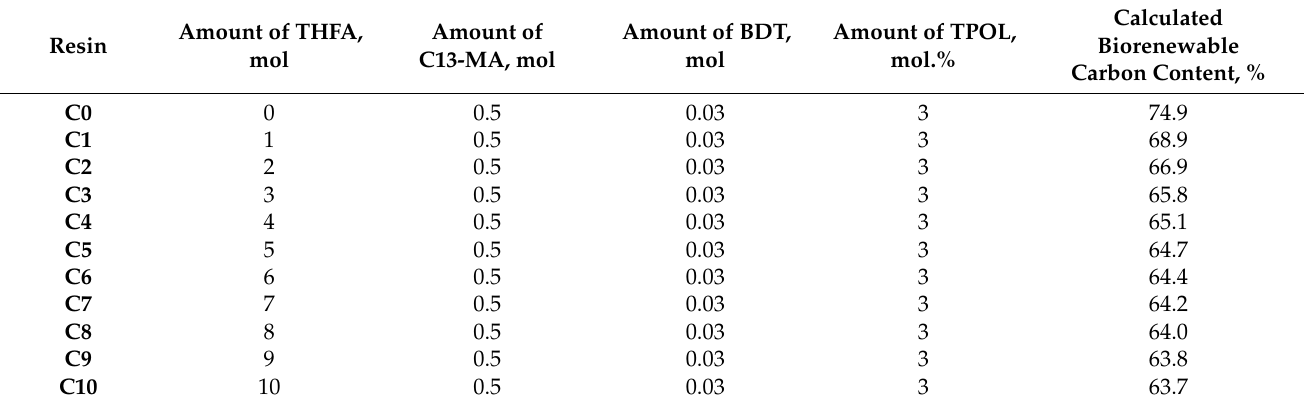
Table 1. Composition of resins C0 – C10 .